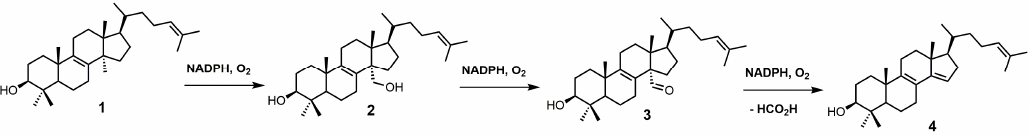
Figure 2. Conversion of lanosterol ( 1 ) into 4,4-dimethyl-5 α -cholesta-8,14,24-trien-3 β -ol ( 4 ) by sterol 14 α -demethylase (SDM).